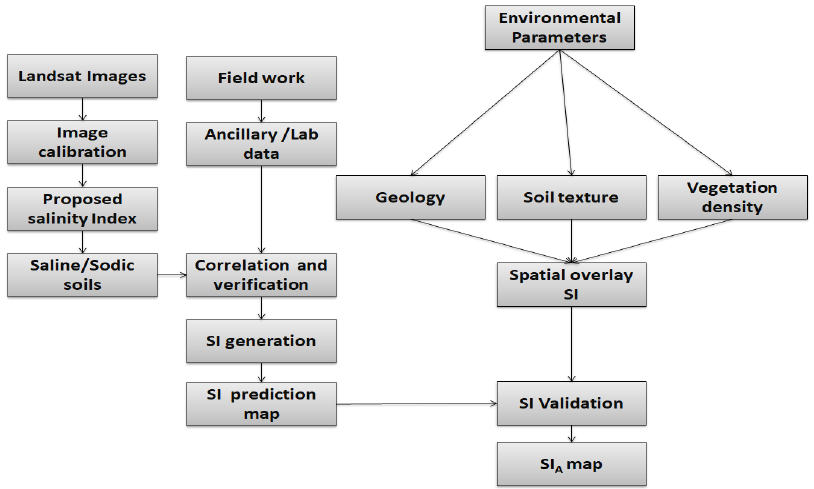
Figure 7 . Flowchart showing the main steps of the study. Figure 7. Flowchart showing the main steps of the